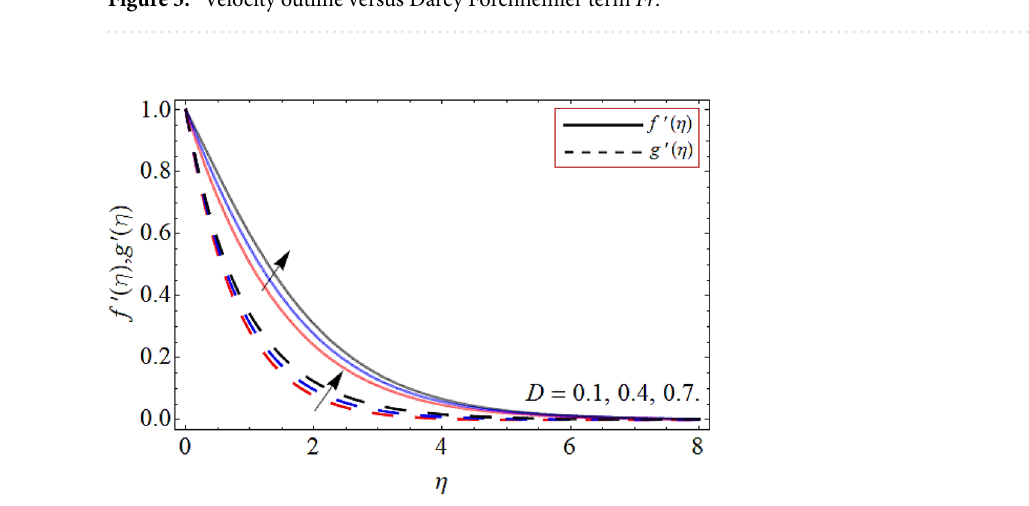
Figure 5. Velocity outline versus Darcy Forchhemier term Fr .